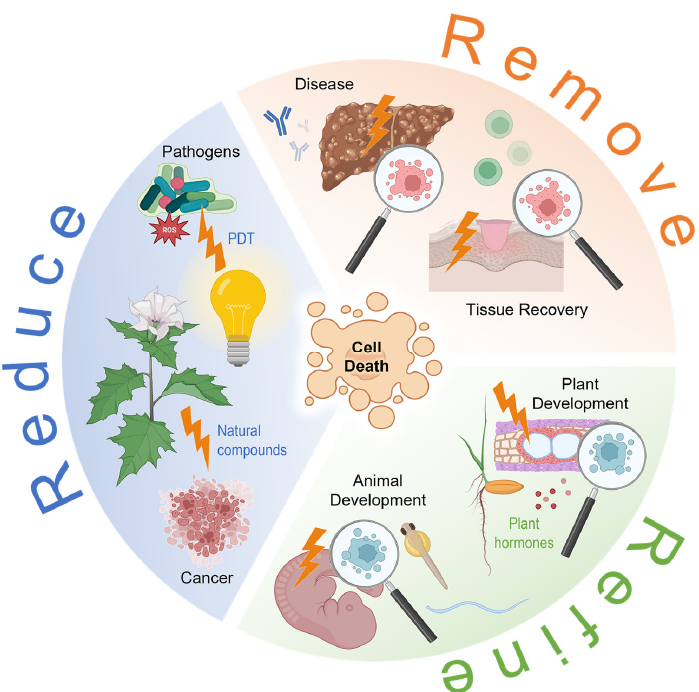
Figure 1. Illustrated overview of the various functions and occurrences of cell death in organisms, with an emphasis on the topics covered in this Special Issue. PDT, photodynamic therapy; ROS, reactive oxygen species. The figure was created using elements from BioRender.com (accessed on 30 March